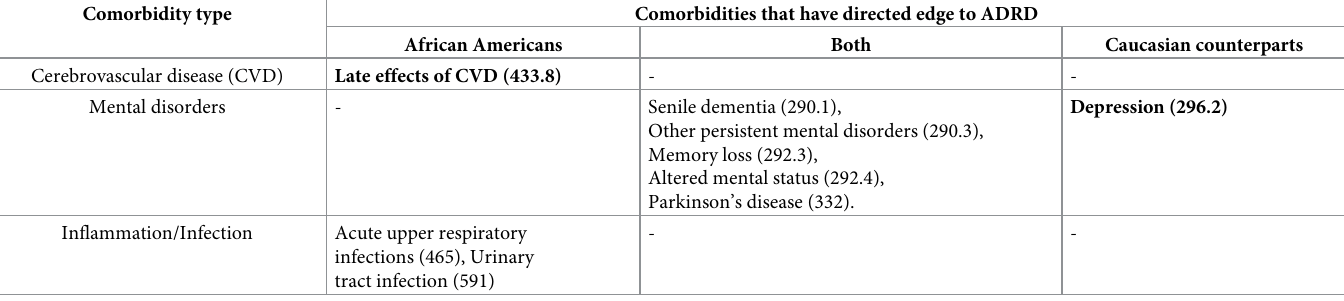
Table 3. Comorbidities (PheWas disease code) with a direct edge to ADRD in Bayesian Network. We selected edges that appeared more than nine times out of ten rep- etitions. More edges in Bayesian Network are at S2 Table. Comorbidity